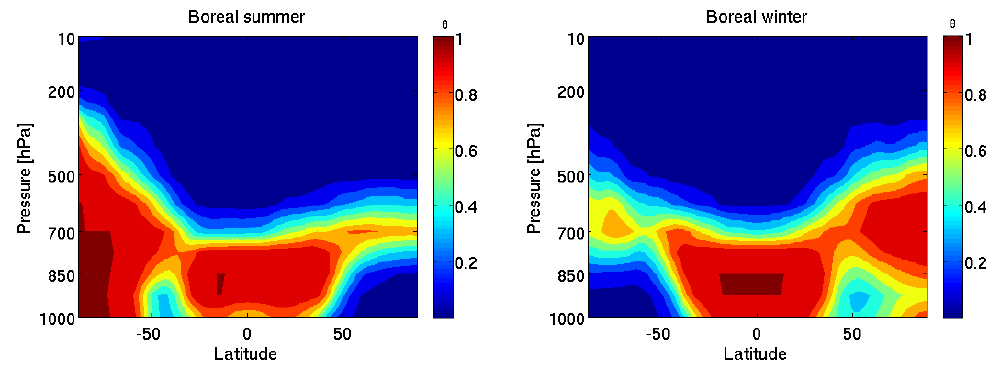
Fig. 6. Model-predicted vertical distributions of seasonal and zonal mean particle-associated fraction, θ , of PFOA (log K oc =2.06, simulated year 1998).